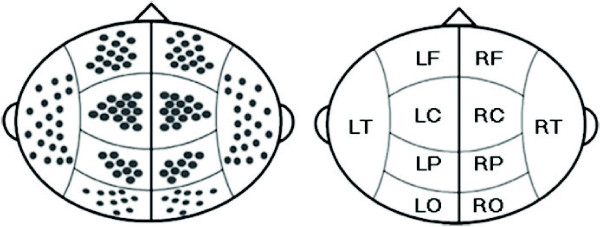
Schematic projection of MEG channels. Head drawing to illustrate the clustering of channels per region. Midline channels were disregarded. L = left, R = right, F = frontal, C = central, P = parietal, O = occipital, T = temporal.